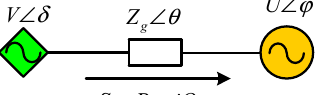
Figure 2. The equivalent circuit of converter interfaced AC microgrid.